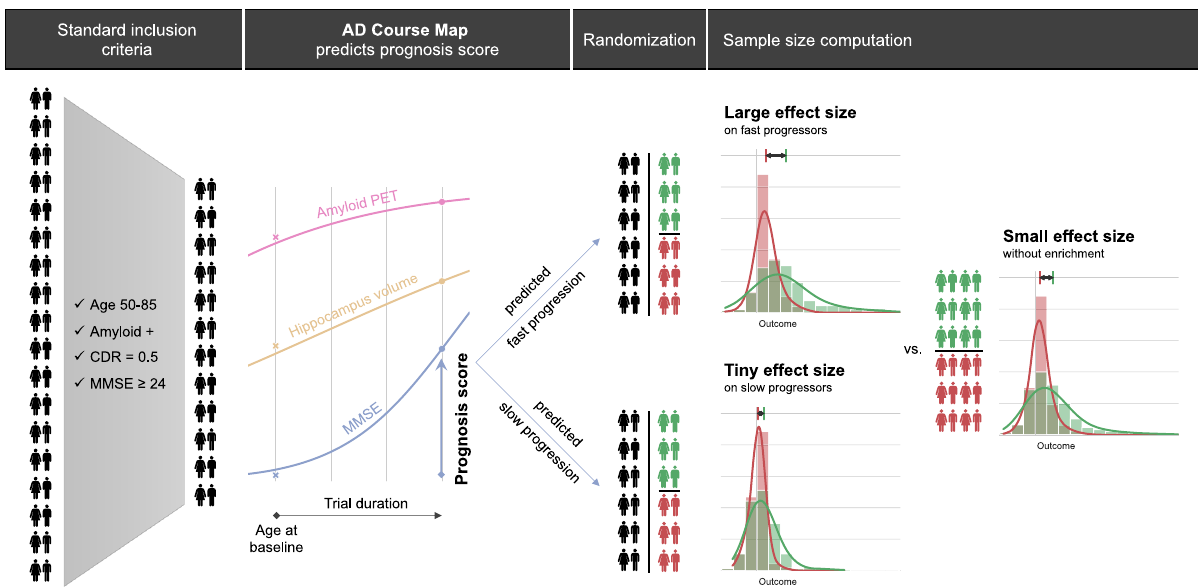
Fig. 4 | Illustration of the prognostic enrichment procedure in a clinical trial. Participants are selected fi rst using standard inclusion criteria and undergo a series of exams. A disease progression model, such as AD Course Map, then forecaststheprogressionofeachparticipant ’ sdataandpredictsiftheparticipant is likely to progress signi fi cantly during the trial, as measured by the predicted outcome change, which is the mini-mental state examination (MMSE) in this